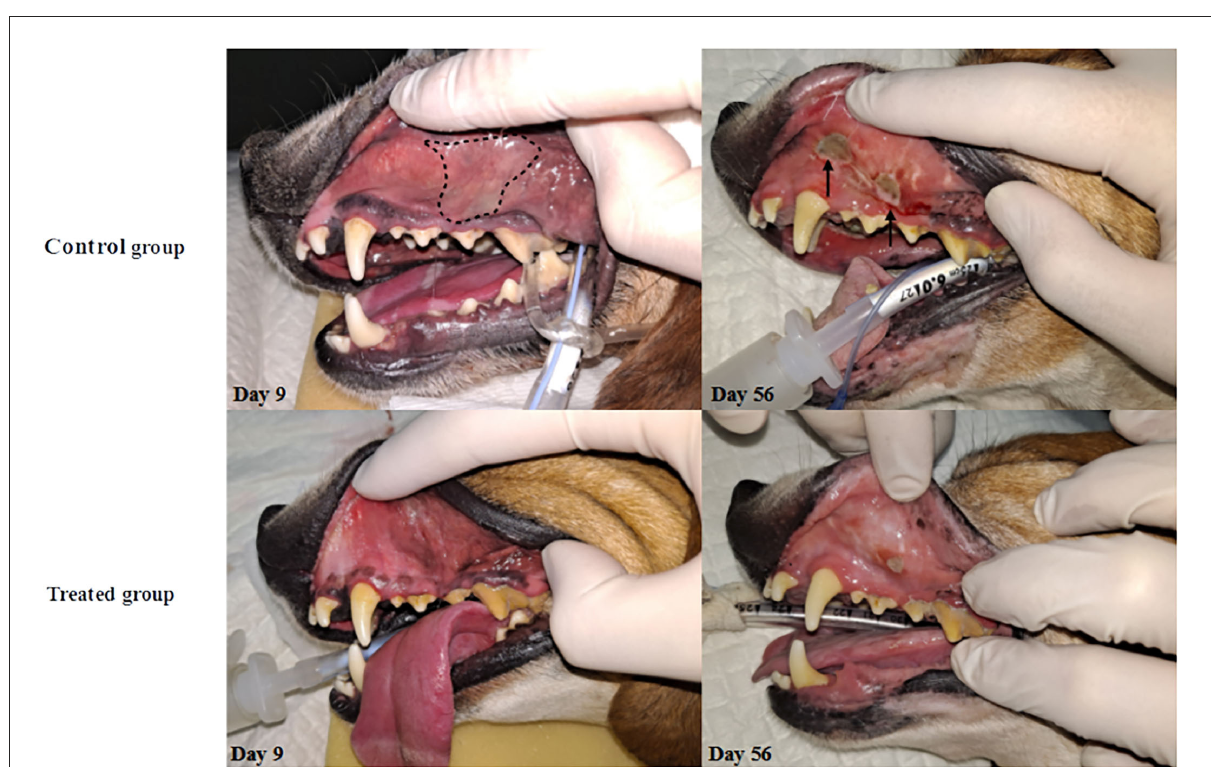
FIGURE1 Changes in oral mucosa after irradiation. The onset of RIOM was observed on day 9 as a form of erythema on oral mucosa and the presence of pseudomembrane (whitish-discoloration). Notably, pseudomembrane was only observed in the control group on day 9 (dashed line). After the ulceration phase begins, the control group showed accelerated progress of the disease with bleeding and edematous changes of oral cavity mucosa (solid arrow) while the treated group only showed minor ulceration on day